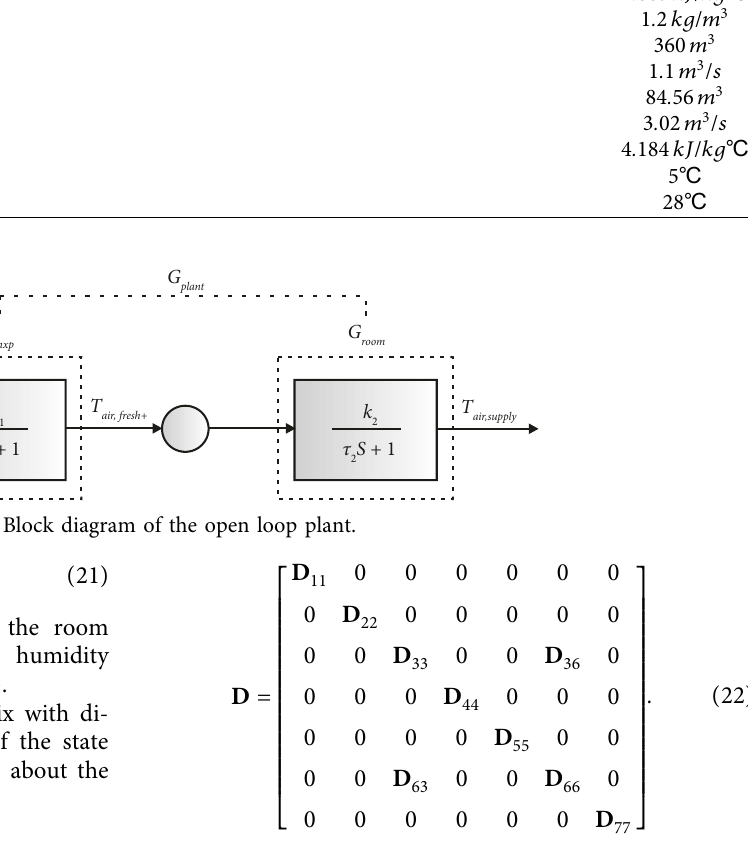
Figure 1: Chiller-FCU setup. Table 1: Parameters of the plant model [37–39].